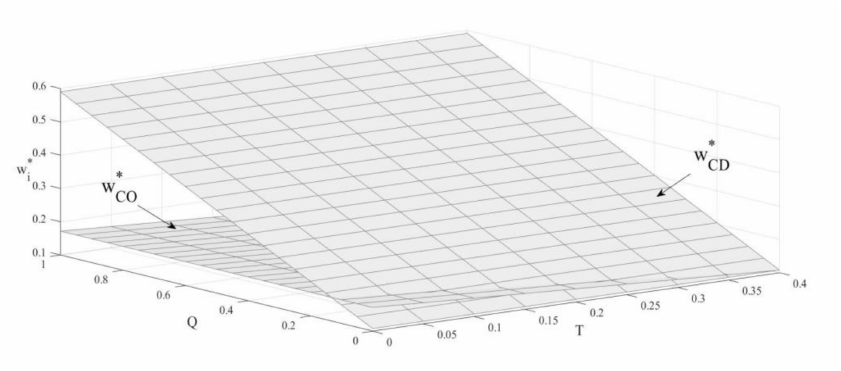
Figure 3. The influence of carbon emission constraint and carbon trade on the unit outsourcing